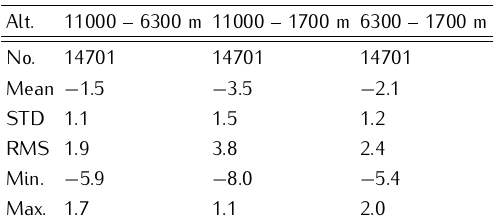
Table 5. Statistics of the residual gravity anomalies on the ground. Units in mGal. Alt.